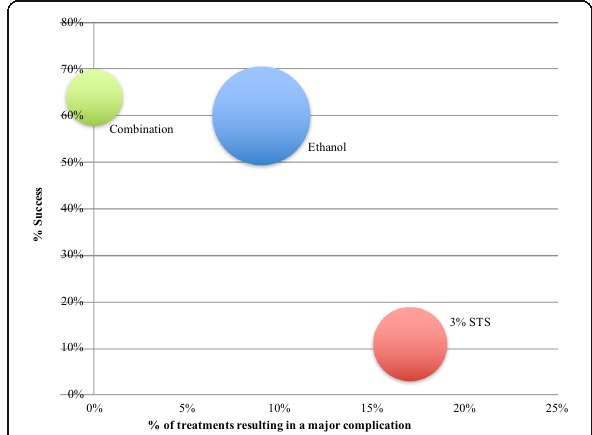
Fig. 3 Success rate versus complication rate for each sclerosant. Size of dot corresponds to the number of times agent was used. Single treatment with bleomycin excluded